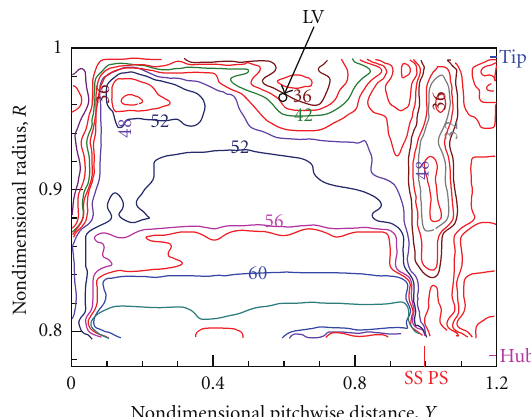
Figure 13: Relative flow angle contours at the exit of rotor (wps) for φ = 0 . 55.